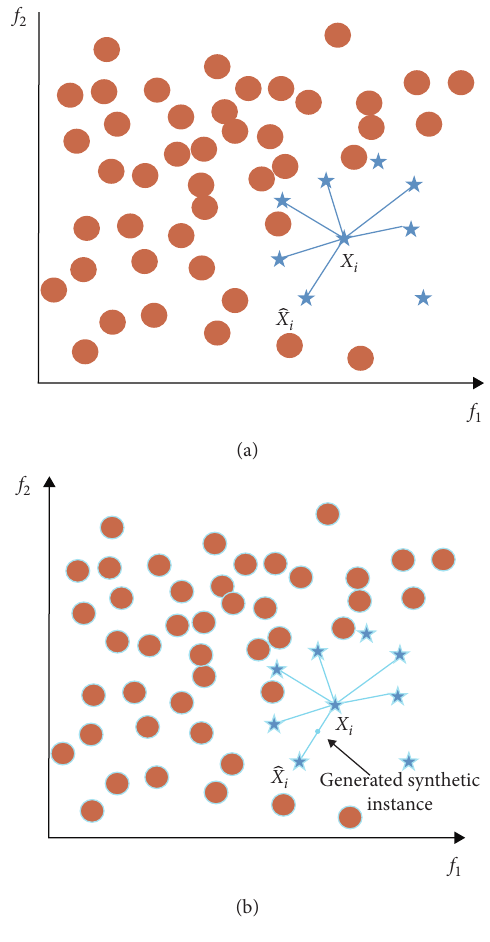
Figure 3: SMOTE algorithm